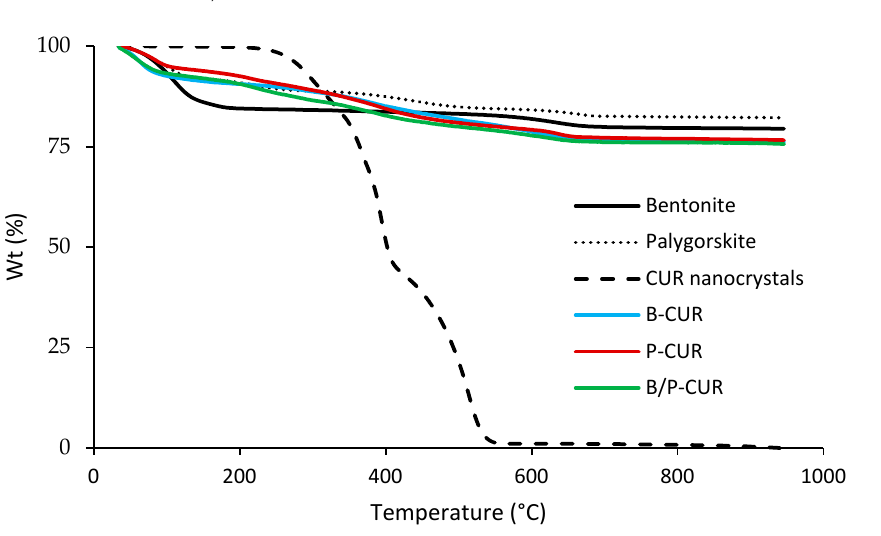
Figure 6. TGA curves of pristine components and curcumin nanocrystal-loaded hydrogels (B-CUR, P-CUR, and B/P-CUR).